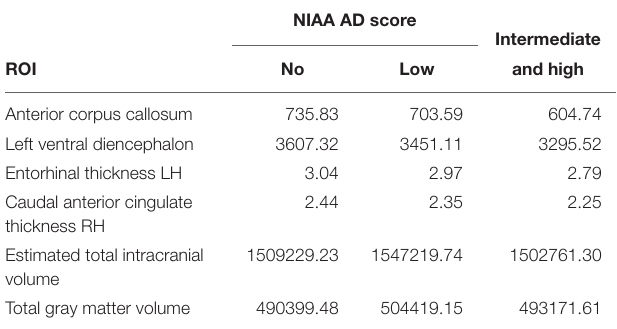
TABLE 3 | Average critical thickness for all three groups according to the NIAA ABC score for neuropathological change of AD for all significantly associated ROI of the post hoc analyses as well as for total intracranial and gray matter volume.